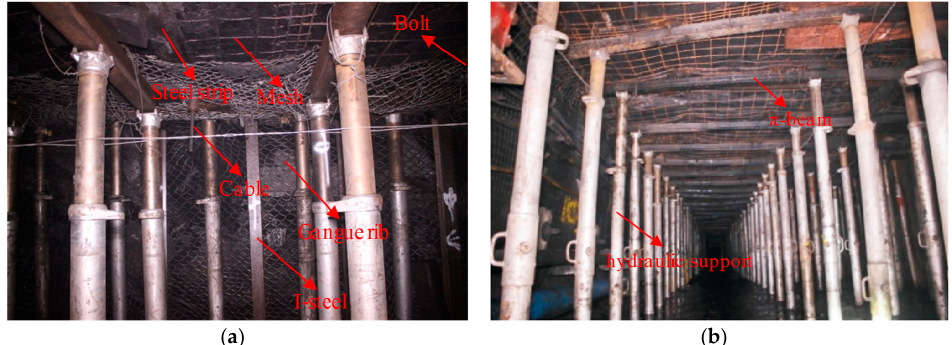
Figure 19. Support system installation in the entry: ( a ) Active flexible support system; ( b ) passive rigid support system.